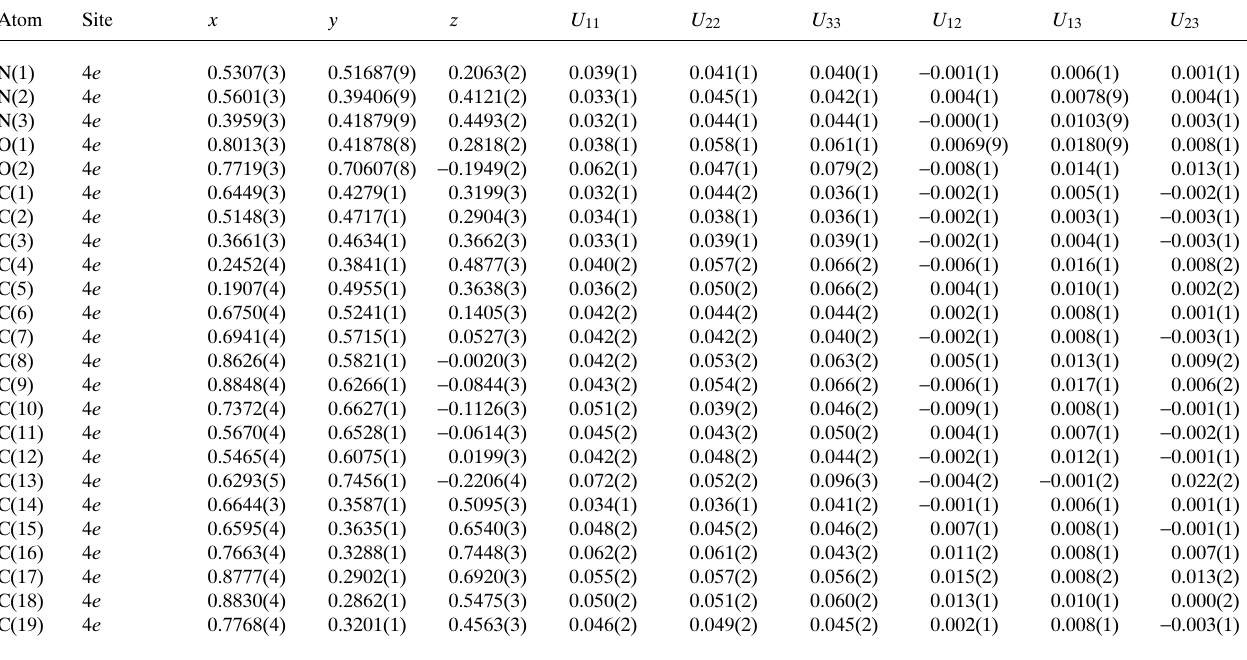
Table 3. Atomic coordinates and displacement parameters (in Å 2 )